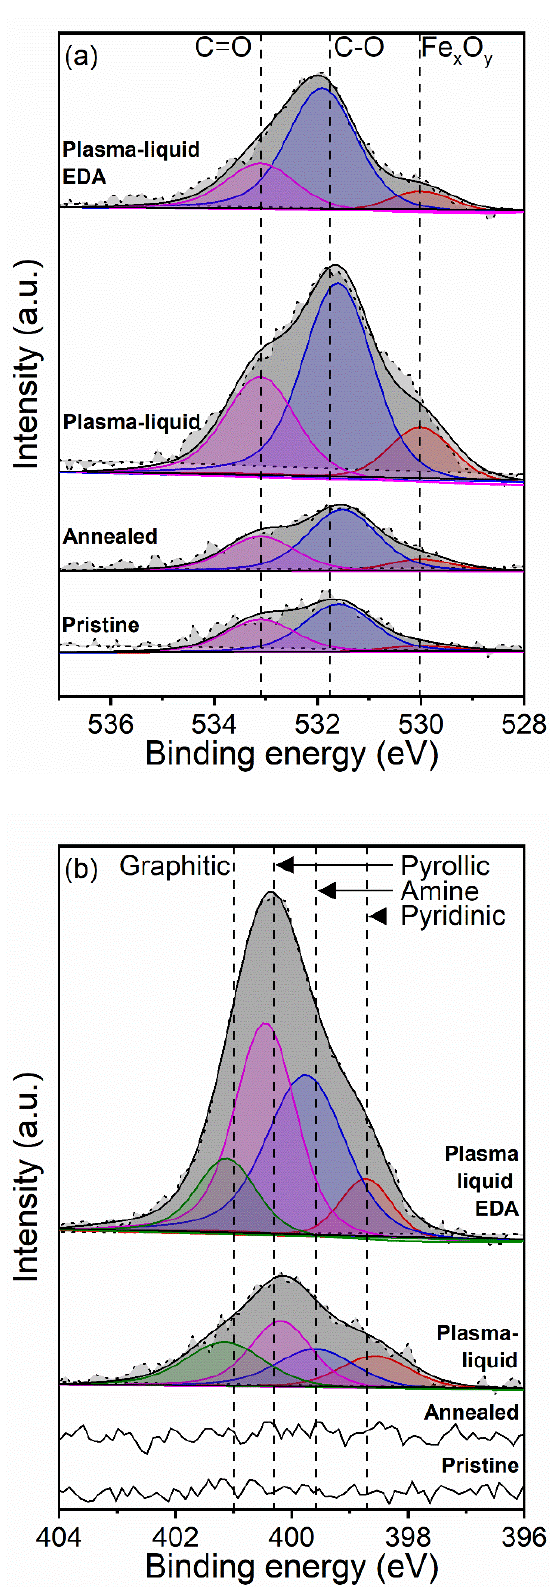
Figure 4. High-resolution X-ray photoelectron spectra of ( a ) oxygen and ( b ) nitrogen for pristine and pre-annealed carbon nanotube ribbons.